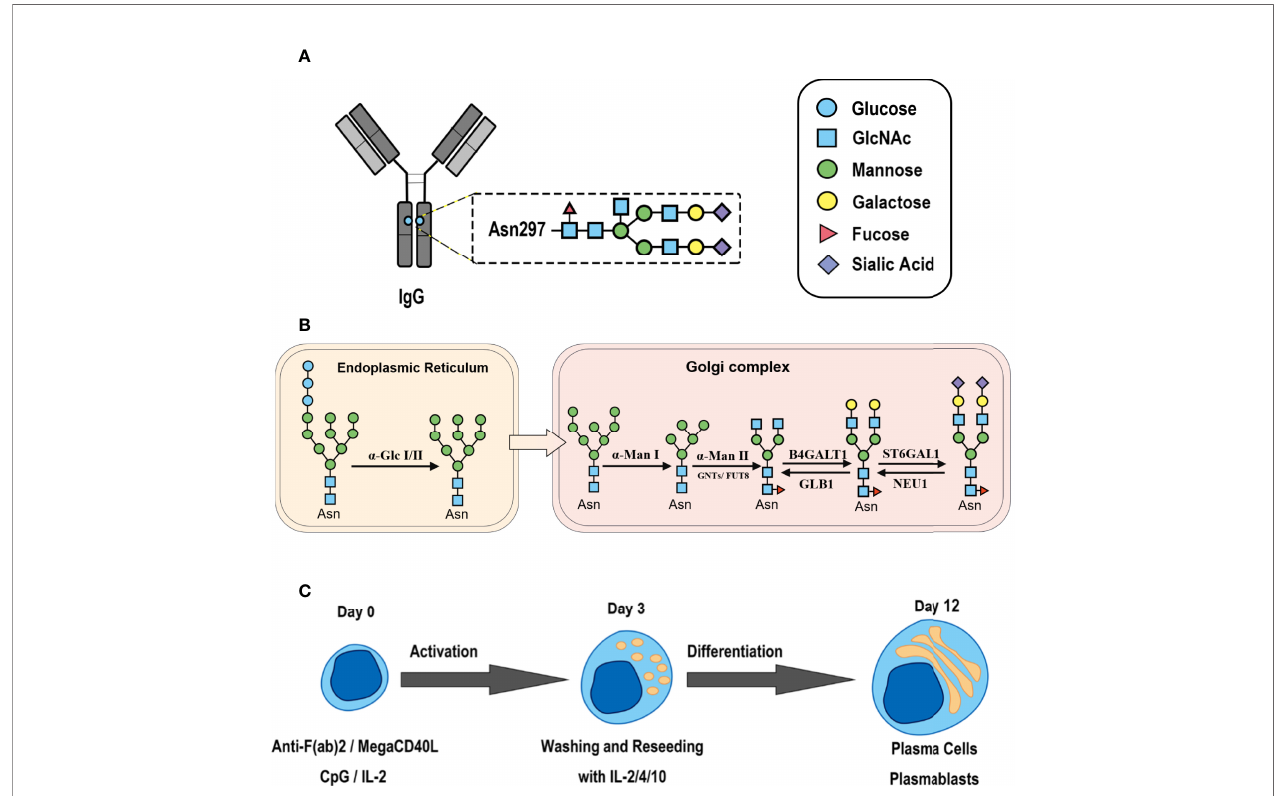
FIGURE 1 | Synthesis of N-glycan in IgG and the two-step differentiation system of B cells. (A) Conserved repertoire of an N-linked glycan attached to the Fc domain of IgG at Asn297, which has a biantennary core heptasaccharide consisting of a chain with two N-acetylglucosamines (GlcNAc) and a mannose, followed by two mannose branches and a further GlcNAc following each mannose. The optional residues of a core fucose, a bisecting GlcNAc, one or two galactoses, and sialic acids can attach to the core structures to enrich the structural diversity of IgG. (B) Sythesis of N-glycan in B cells. Various a -mannosyltransferases (ALGs) catalyze the synthesis of triantennary Glc 3 Man 9 GlcNAc 2 glycans in the lumen of the endoplasmic reticulum (ER). Then, a -glucosidases I and II remove a -glucose from the sugar chain to form the high-mannose type Glc 3 Man 5~9 . After transfer into the Golgi complex, a -mannosidase I trims mannose residues from the N-glycan to form Man 5 GlcNAc 2 , which is the core structure of hybrid-type N-glycans. Next, a -mannosidase II removes the two a -mannoses from the glycan chain, and two GlcNAc sequences are catalyzed by N-acetylglucosaminyltransferases (GNTs) to form the biantennary heptasaccharide core structure Man 3 GlcNAc 4 . Then, a -1,6- fucosyltransferase 8 (FUT8) catalyzes the addition of fucose to the core structure. b -1,4-Galactosyltransferase 1 (B4GALT1) and b -galactosidase (GLB1) are responsible for the addition and removal of galactose. b -Galactoside a -2,6-sialyltransferase 1 (ST6GAL1) and sialidase-1 (NEU1) transfer and cleave sialic acid to/ from oligosaccharides. (C) B cell in vitro differentiation system. First, B cells were activated by anti-F(ab ’ ) 2 , MegaCD40 L, CpG ODN, and IL-2 for 3 days and then washed and reseeded with IL-2, IL-4, and IL-10 to help activate B cell differentiation into antibody-secreting cells (ASCs) for up to 12